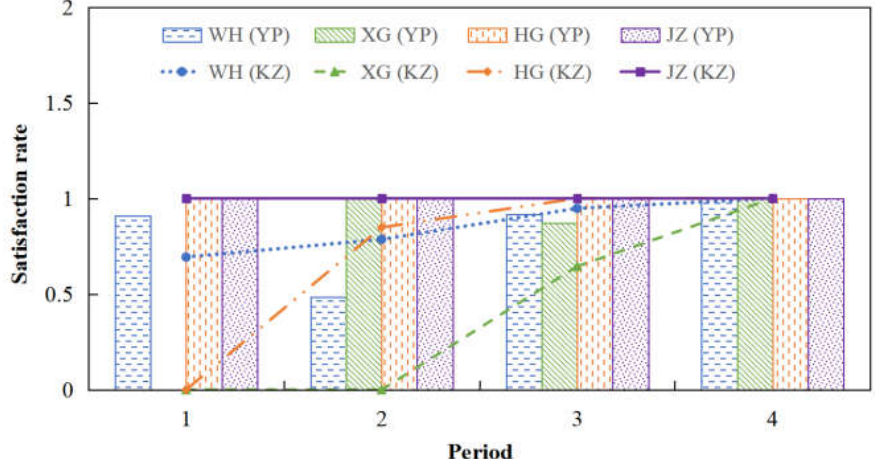
Figure 9. Satisfaction rate of emergency materials at each affected site in each time period based on the balance-criterion.